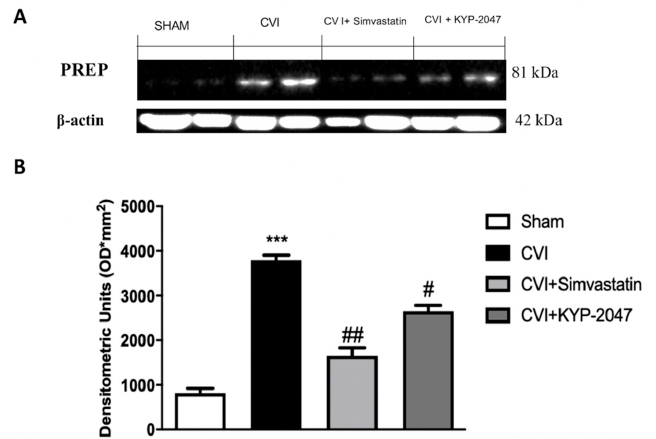
Figure 1. The inhibitor effects of KYP-2047 on prolyl oligopeptidase (POP) in chronic venous insufficiency (CVI) mouse model. Western Blot analysis to detect PREP in vein samples, clearly